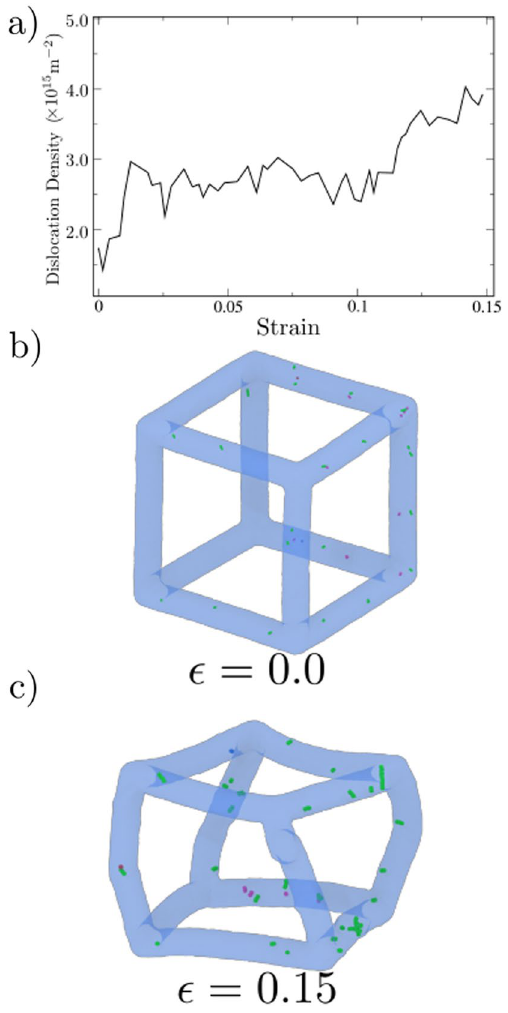
Figure 3. ( a ) Total dislocation density vs. strain. ( b , c ) Snapshots showing dislocations. The blue semitransparent region corresponds to the nanoframe surface, while green and pink lines correspond to 1 / 2 (cid:31) 111 (cid:30) , and (cid:31) 100 (cid:30) dislocations, respectively. ( b ) Zero strain and ( c ) 0.15